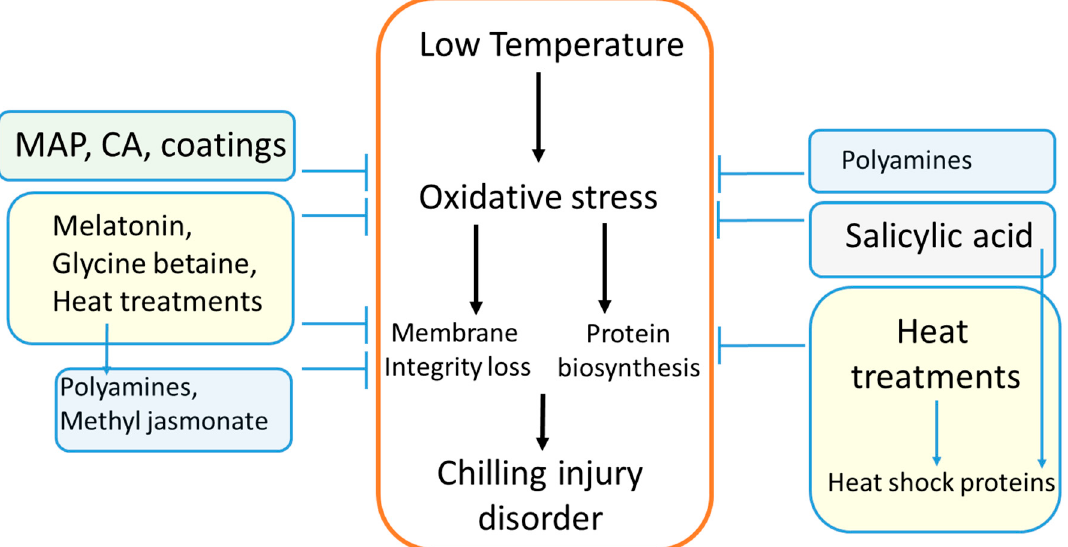
Figure 6. Hypothesis of pomegranate chilling injury (CI) incidence during long-term storage and the possible targets of postharvest treatments. Accordingly, CA, MAP, and coating systems would work mainly by decreasing oxidative stress by reducing the presence of internal oxygen within the fruit. On the other hand, heat treatments may exert their effects by inducing heat shock proteins in a hierarchical stress response model or alternatively by reducing oxidative stress and preserving membrane fluidity and by inducing polyamines. Furthermore, applied polyamines, melatonin, and glycine betaine may have a dual role of reducing oxidative stress and preserving membrane integrity. SA attenuates oxidative stress and induces heat shock-like proteins while methyl jasmonate preserves membrane integrity. Proposed hypothetical model is based on references from Section 3.3. Proposed model could be the basis of a hurdle strategy combining different technologies to attenuate CI in a similar fashion as previously described for husk scald disorder in pomegranate fruit [17].